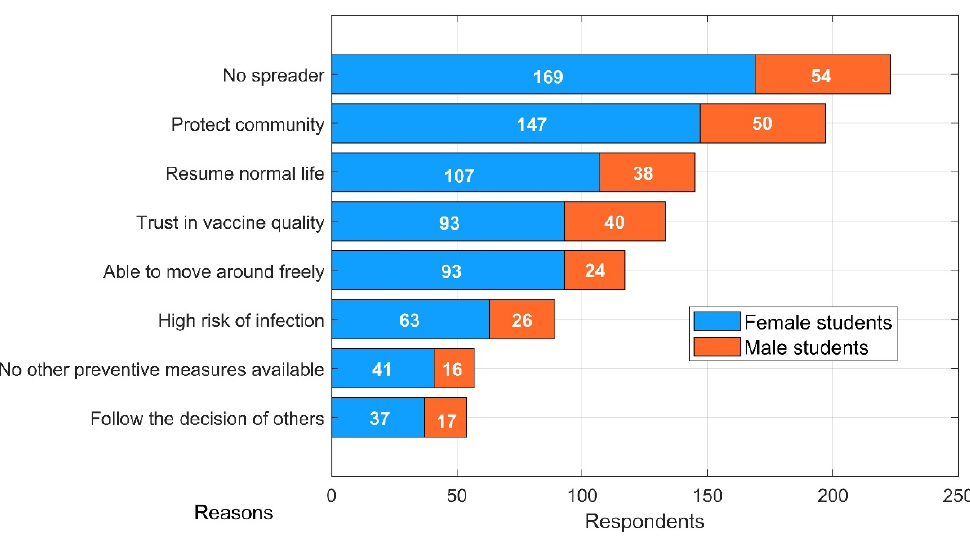
Figure 3. Reasons for hesitation regarding getting vaccinated.